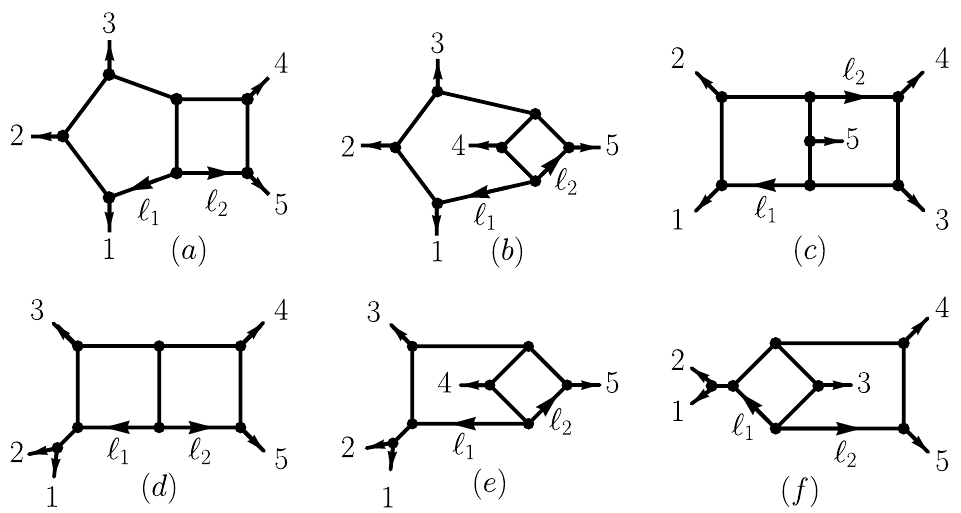
Figure 1 . Diagram topologies entering the local representation of the two-loop (cid:12)ve-point integrand of N = 8 supergravity [24]. Each diagram has an associated kinematic numerator which we give in the main